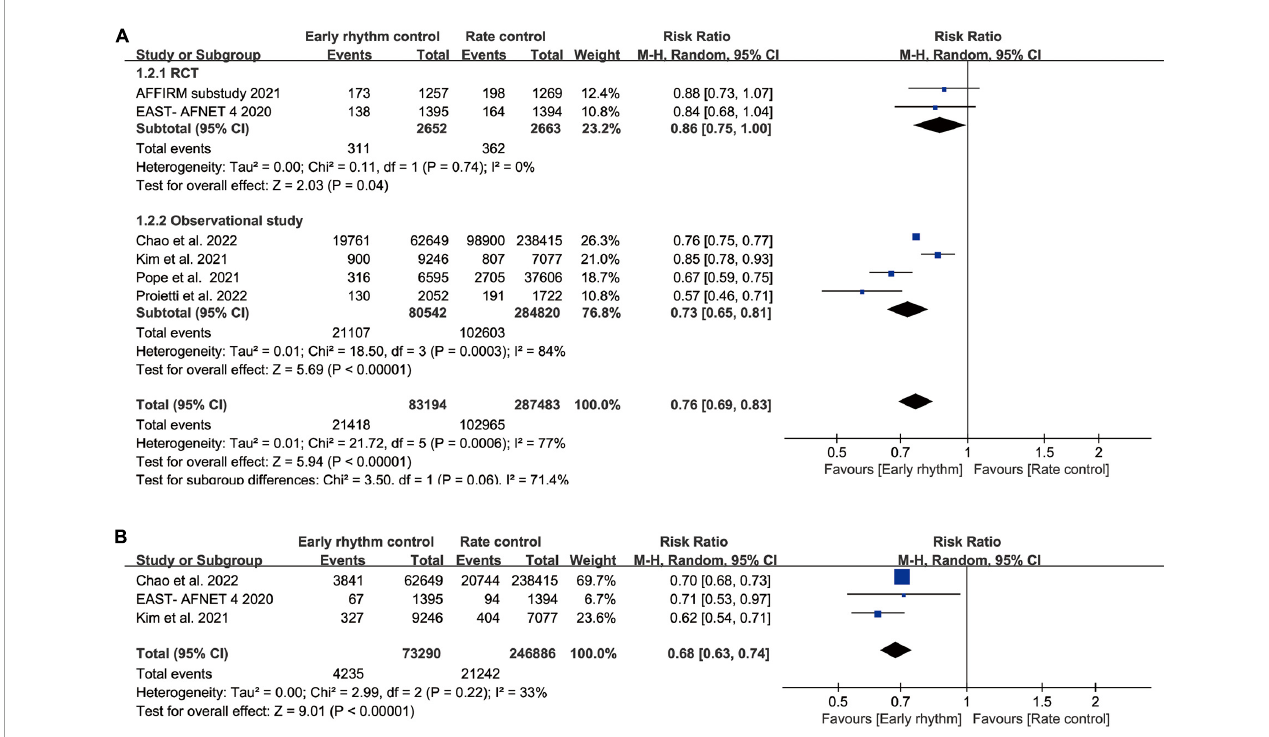
FIGURE2 (A) Forest plot showing all-cause mortality between early rhythm group and rate group. (B) Forest plot showing cardiovascular mortality between early rhythm group and rate group.